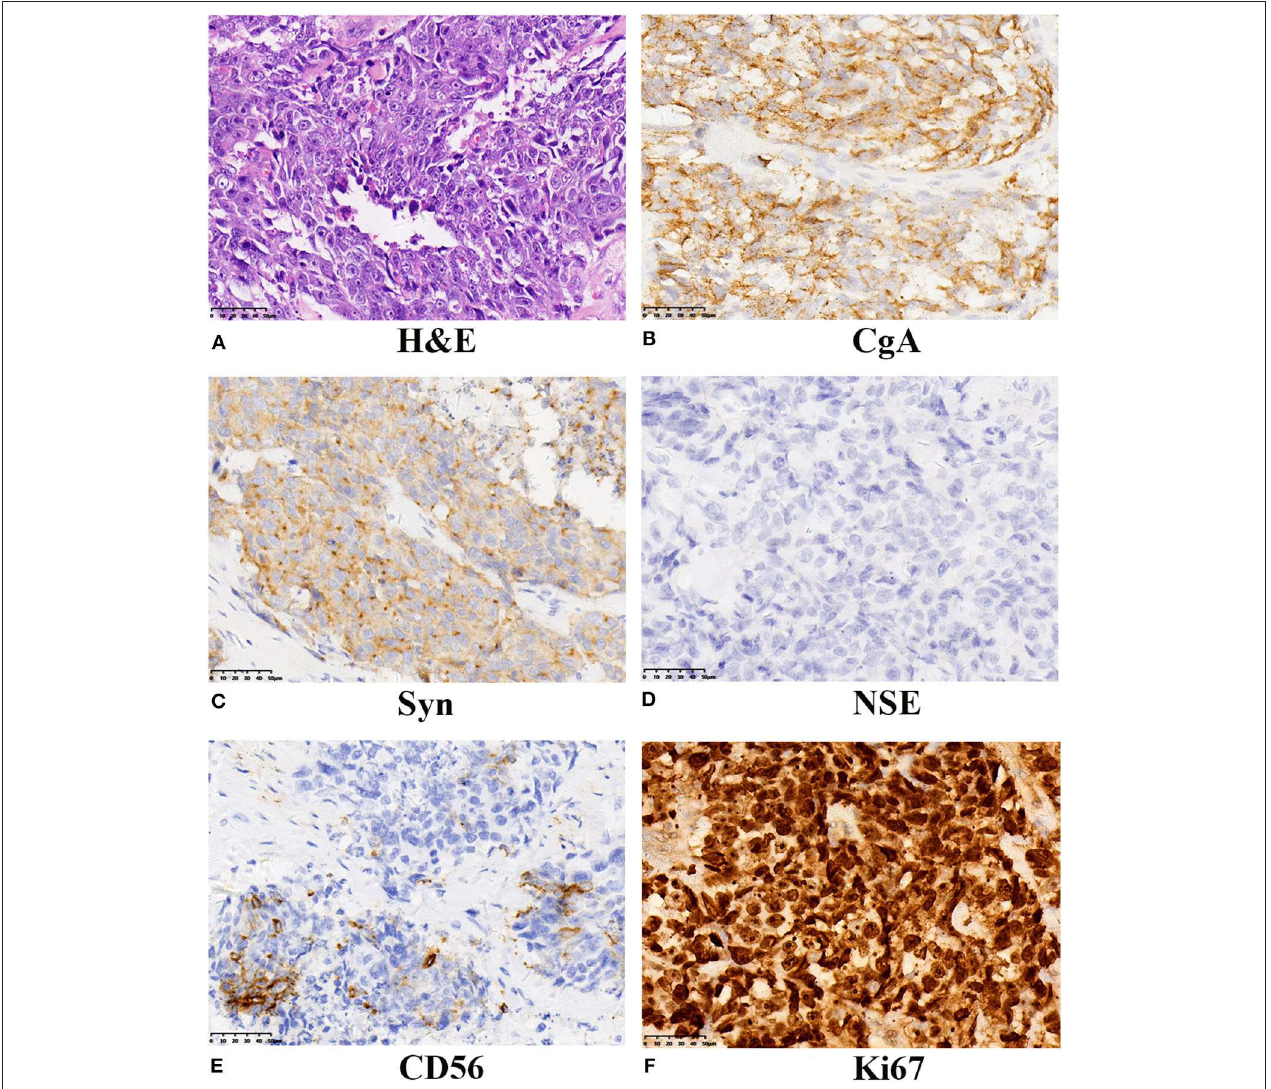
FIGURE 1 | Histochemical and immunohistochemical examinations of the tumor from our case. (A) LCNEC of the bladder showed large cells with large nuclear size, prominent nucleoli, and abundant cytoplasm. (H&E staining, × 400). The neoplasm displayed positive expression of CgA (B) , strong and diffused expression of Syn (C) , absent NSE expression (D) , positive for CD56 (E) , and the proliferative index Ki67 was 90% (F) . A final diagnosis of LCNEC was performed. LCNEC, large cell neuroendocrine carcinoma; H&E, hematoxylin and eosin; CgA, Chromogranin A; Syn, synaptophysin; NSE, neuron specific